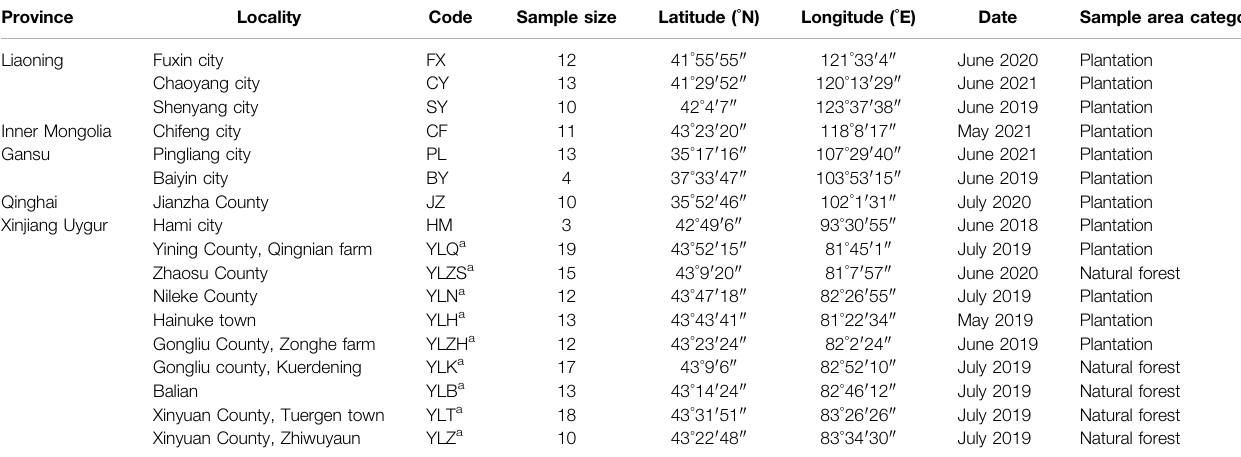
TABLE 1 | Sampling information of 17 geographical populations of A. mali in China. Province